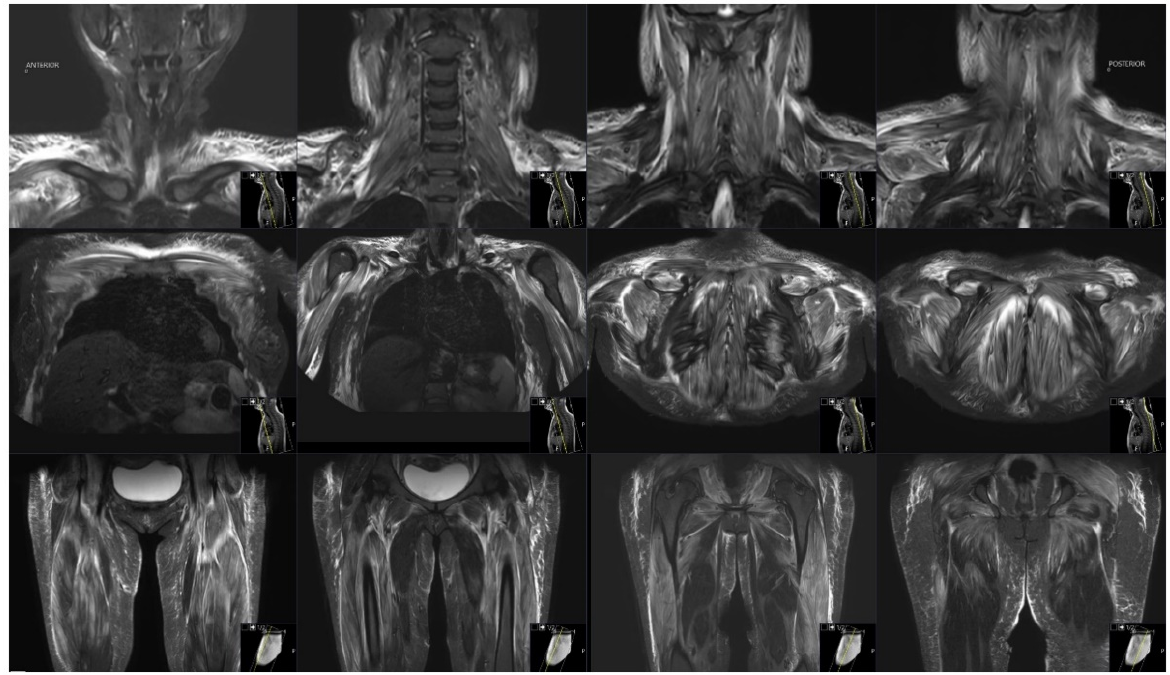
Figure 1. MRI of deltoid and thigh muscles. Bilateral patchy and diffuse areas of high T2/ STIR signal intensity in muscles are seen, consistent with active myositis.